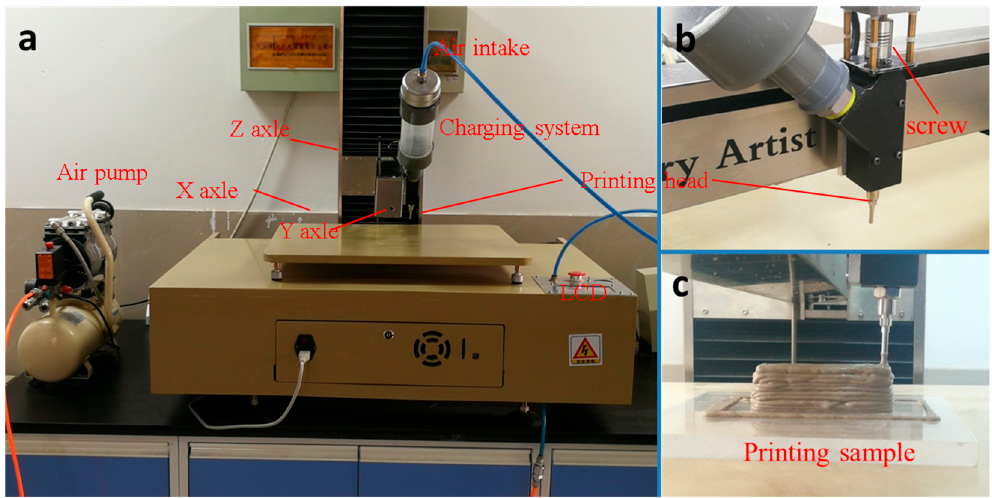
Figure 2. ( a ) 3D printer, ( b ) extrusion system and ( c ) printed sample.